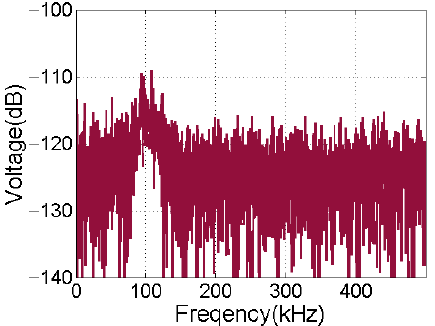
Figure 23. Background noise of channel #56.